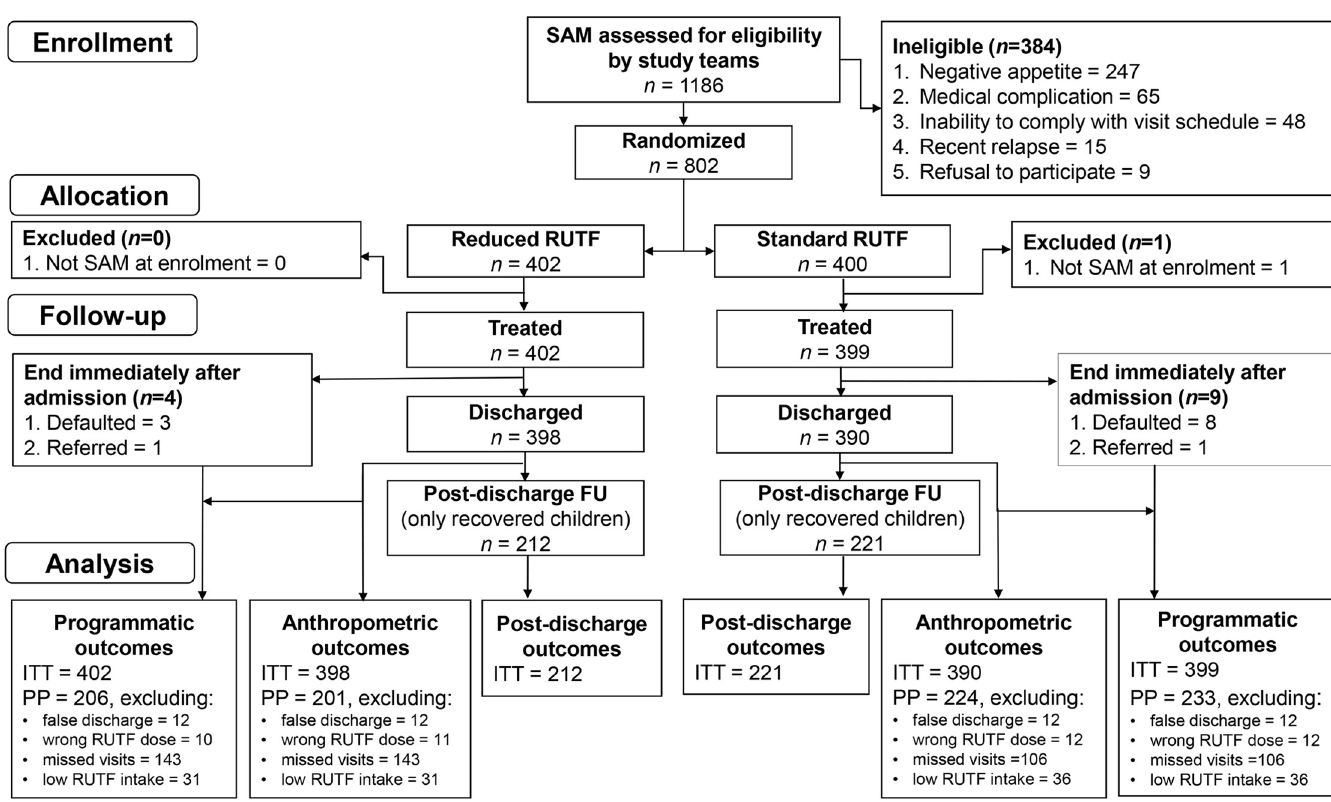
Fig 1. Patient flowchart. FU, follow-up; ITT, intention to treat; PP per protocol; RUTF, ready-to-use therapeutic food; SAM, severe acute malnutrition.